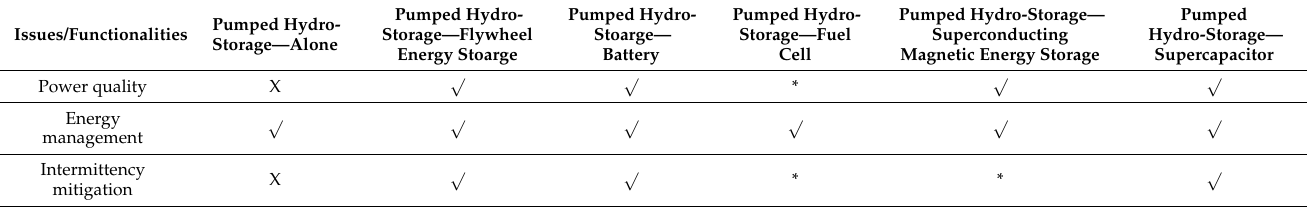
Table 4. Energy storage hybridization opportunities to mitigate various issues while deploying large- √ scale VSGs. X shows no opportunity, provides a significant potential, and * shows a possibility of